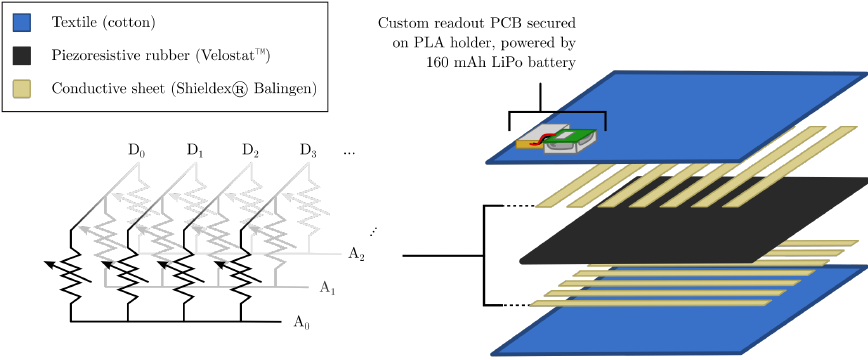
Figure 1. Smart textile structure and principle. The Velostat™ in between two orthogonal sets of conductive strips behaves as a grid of variable